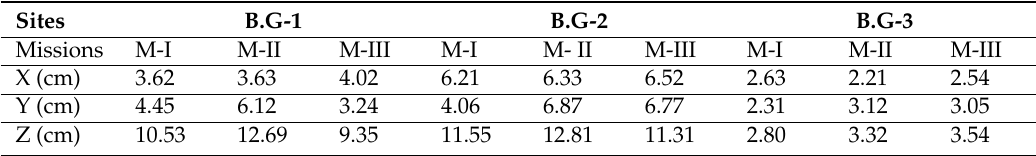
Table 5. FIS errors in X, Y and Z of the GCPs.